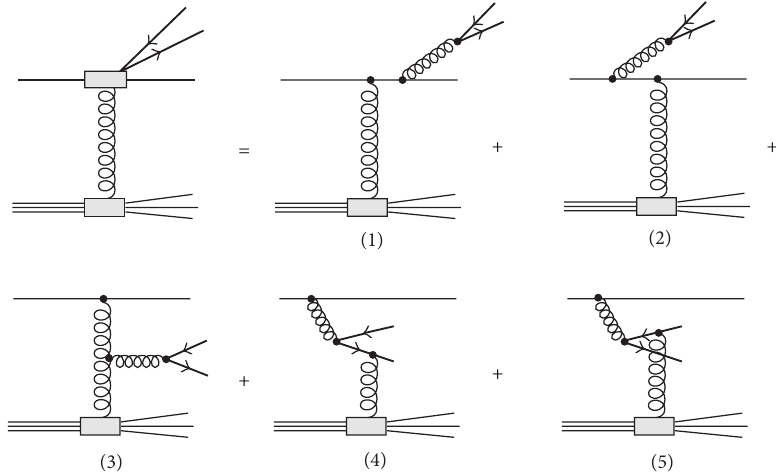
Figure 13: Five different topologies contributing to inclusive 𝑄𝑄 production in quark-proton scattering. These can be split into two gauge- invariant subsets of amplitudes as described in the